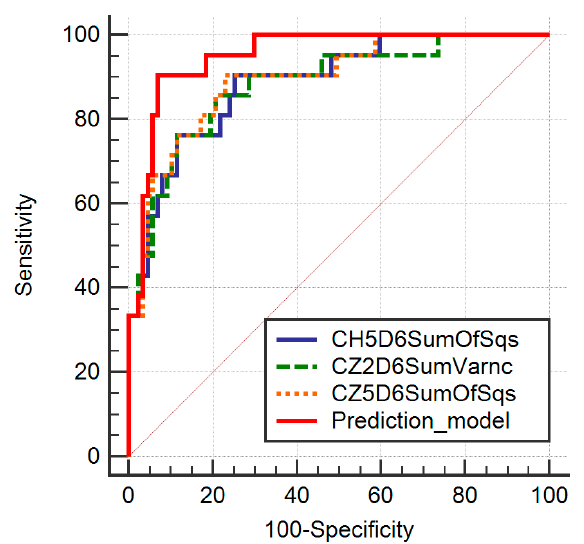
Figure 3. Receiver operating characteristic curve of the four texture parameters independently associated with the presence of malignant lesions and the prediction model. SumVarnc, sum variance; SumOfSqs, sum of squares.